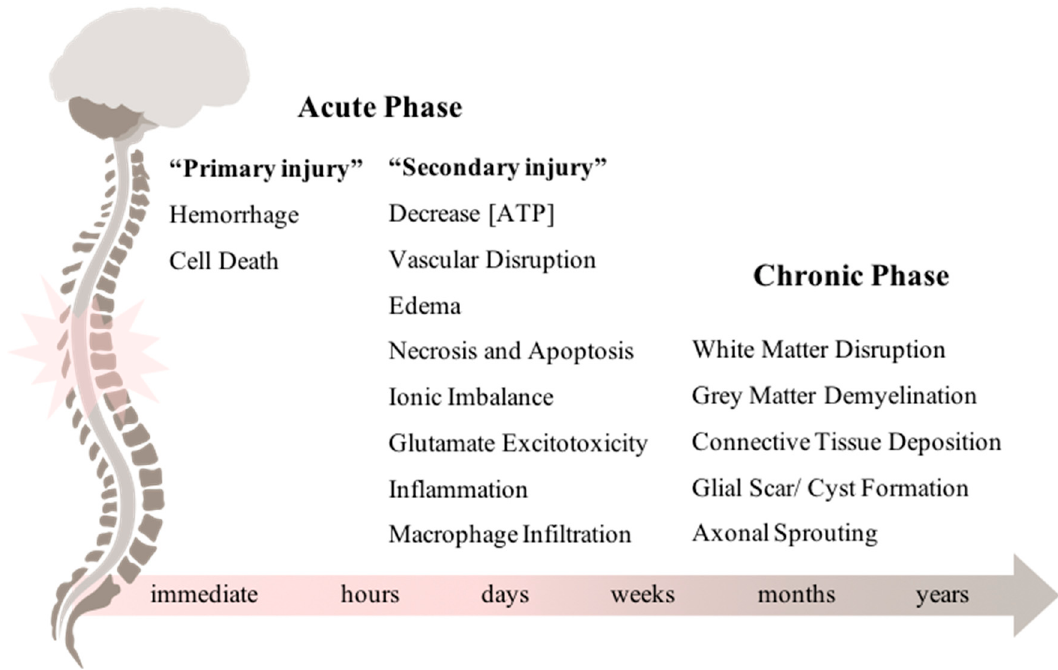
Figure 1. Underlying biological events during acute and chronic phases after spinal cord injury. The primary insult to the spinal cord immediately leads to a cascade of events that comprises the “secondary injury”. Weeks to months after the acute phase, the chronic phase is established and it may last throughout the patient’s life.